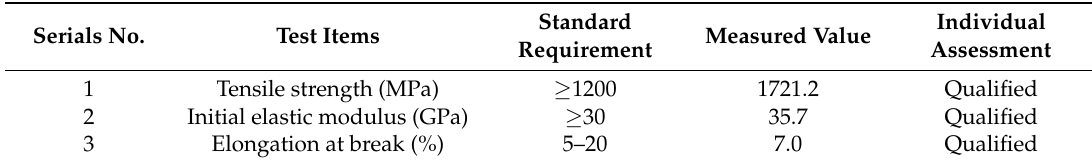
Table 2. Test report results of PVA fiber.